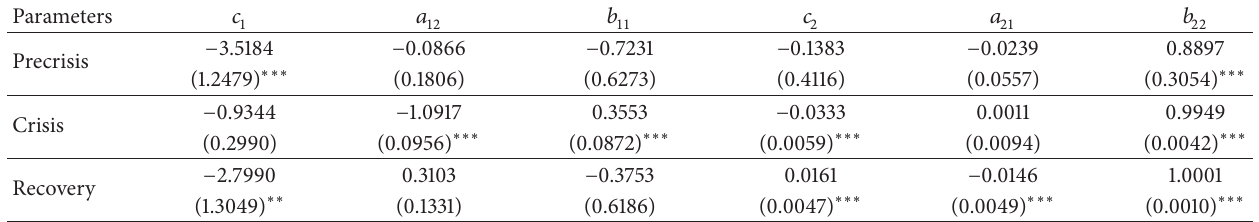
Table 4: Financial contagion analysis between the US and Japan.